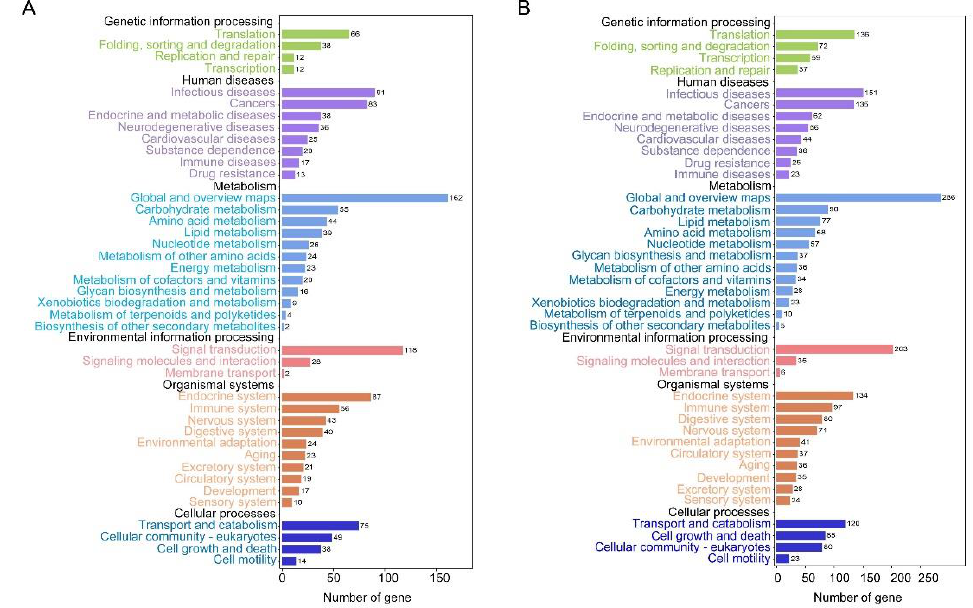
Figure 3. Kyoto Encyclopedia of Genes and Genomes (KEGG) pathway classification of DEGs in the forewing ( A ) and hindwing ( B ) buds of 24 hAE-5th-star nymphs with NlFoxO and Gfp knockdown.